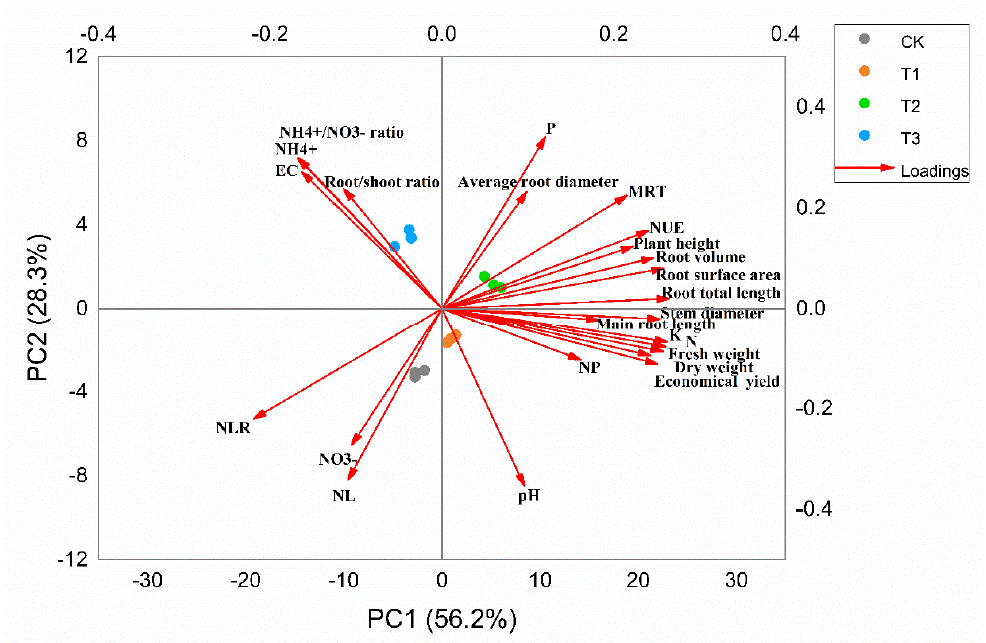
Figure 4. Principal component analysis showing differences and correlations in the investigated parameters of Chinese kale under different NH 4+ /NO 3 −